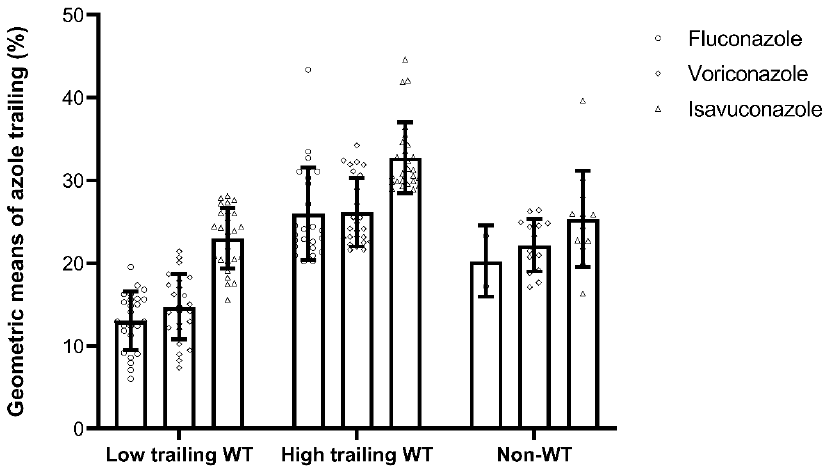
Figure 1. Geometric means of trailing percentages for fluconazole, voriconazole, and isavuconazole among low and high trailing WT and non-WT C. tropicalis isolates. Isolates with fluconazole MICs of ≥64 m/L were excluded from calculating the percentage of trailing due to out-of-dilution ranges. Error bars indicate standard deviations.